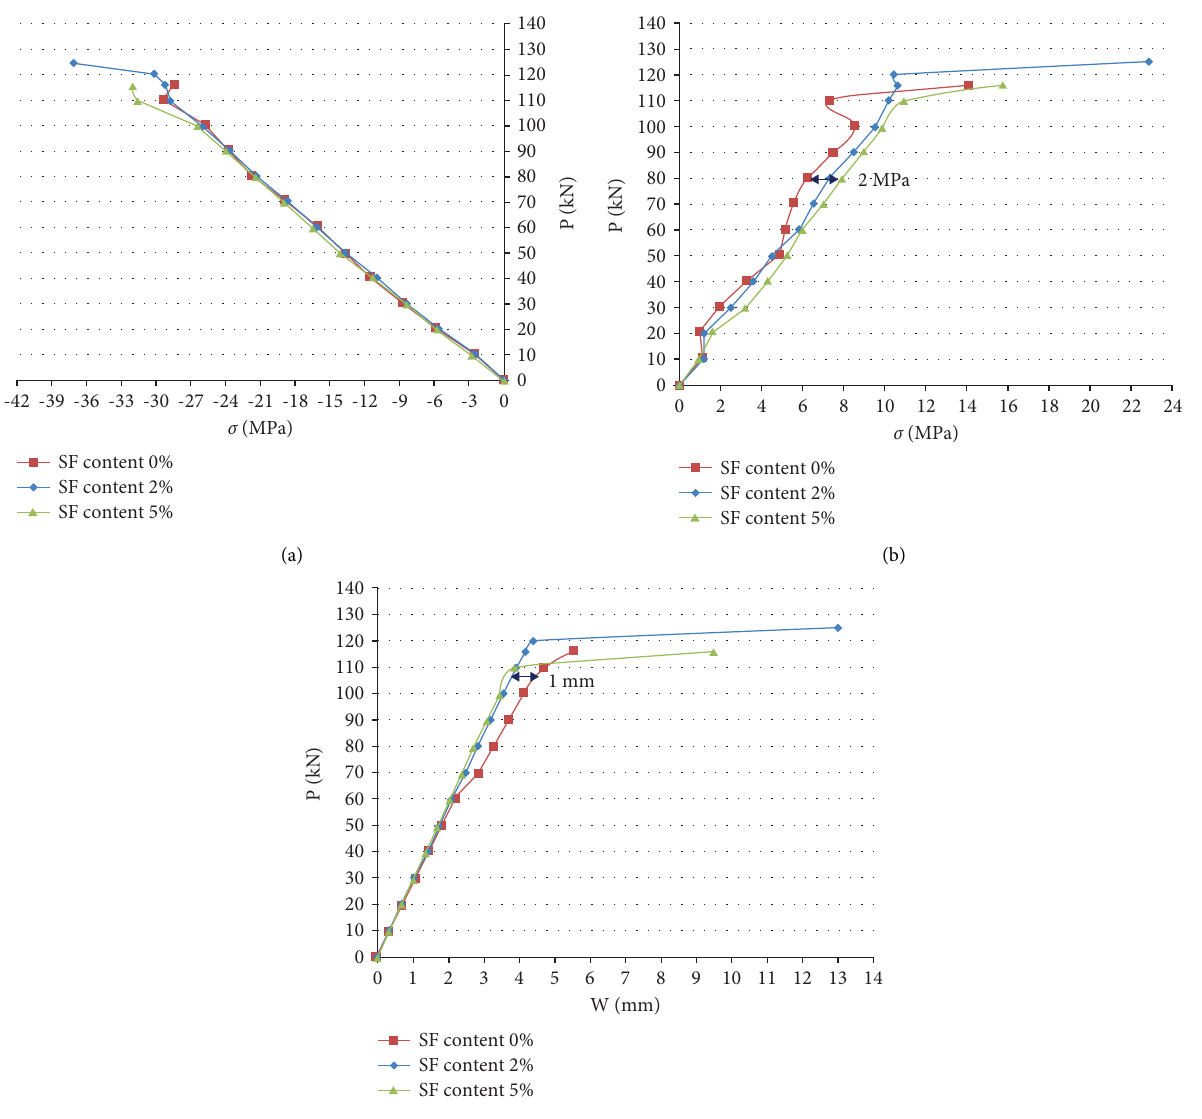
Figure 12: Relationship between load and stress, as well as between load and vertical displacement (efect of SFs): (a) relationship between load and compressive stress, (b) relationship between load and tensile stress. (c) the relationship between load and